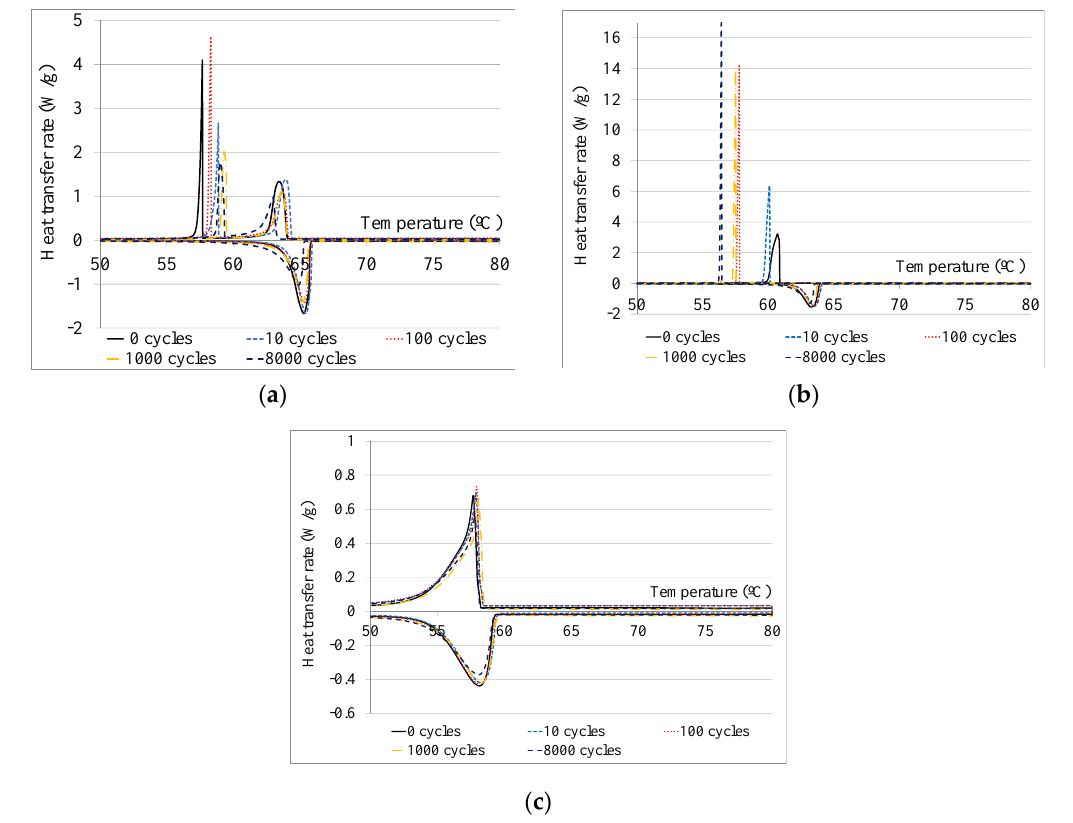
Figure 5. DSC analysis of the cycled PCM. ( a ) RT64HC; ( b ) PureTemp 63; ( c ) THP5860.